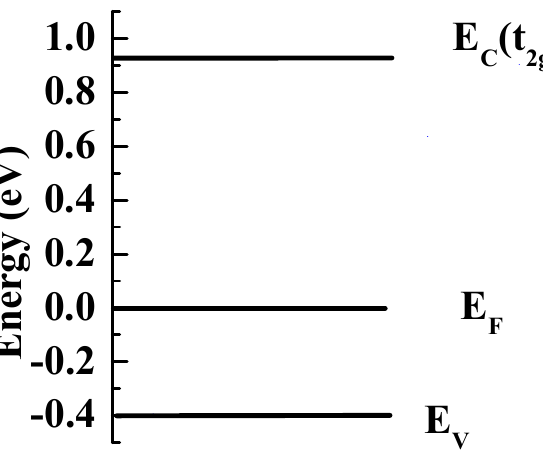
Figure 6. The schematic energy band diagram of RuSb 2 +